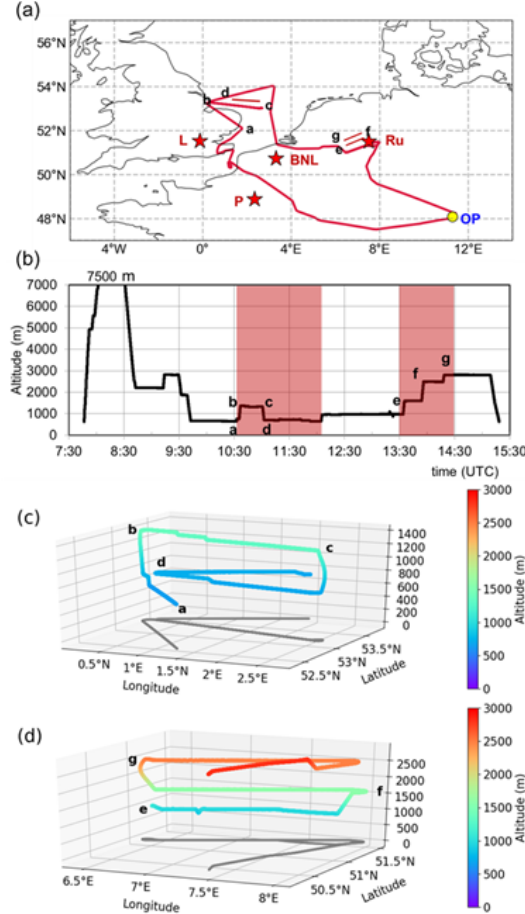
Figure 7. Details of the E-EU-08 flight on the 26 July 2017. The position of the shuttles downwind from London and the BNL/Ruhr area are indicated in red on the map in panel (a) , marked by the red-shaded areas in panel (b) , and as a 3-D depiction in panels (c) and (d) . The flight tracks during the shuttles are shown in panels (c) and (d) in grey. In panel (a) , the EMeRGe MPC targets are shown in red, and the flight track is coloured as in Fig. 4. Main changes in course and altitude are marked as a–g on the graphs for reference. OP indicates the position of the HALO